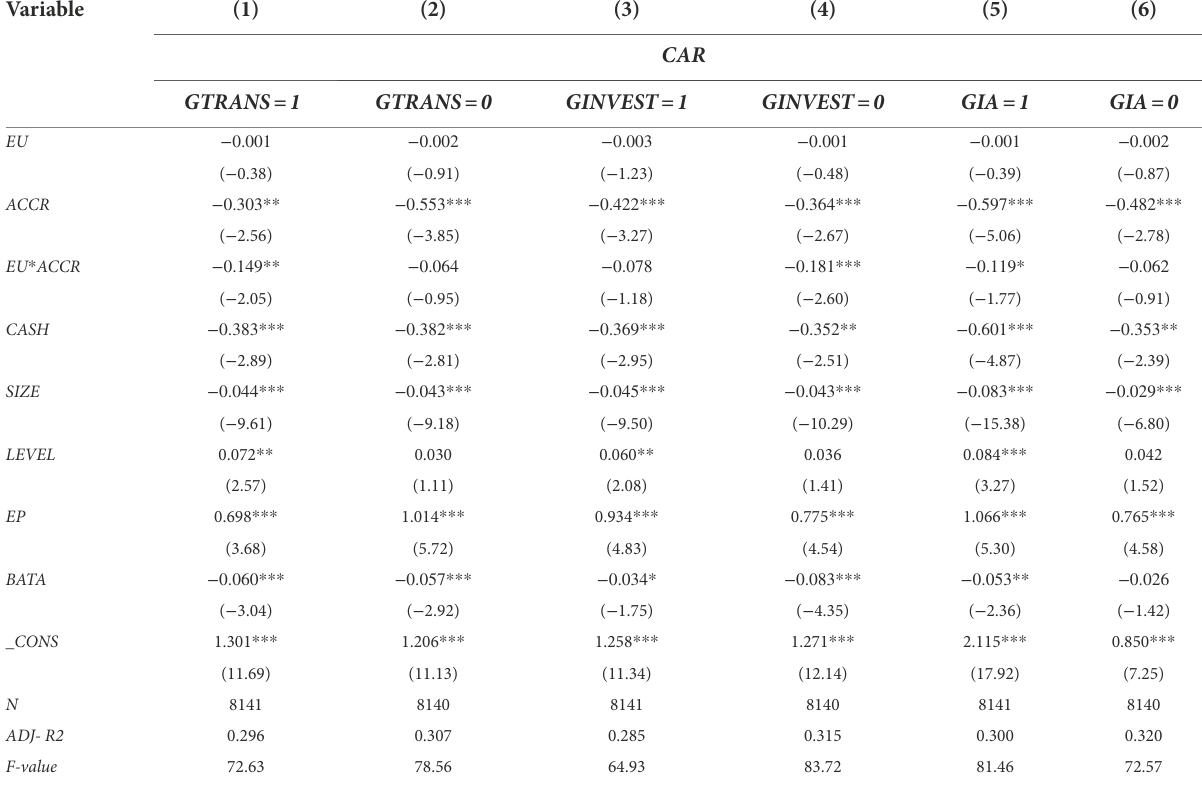
TABLE 12 The mediating effect tests with group regression. Variable